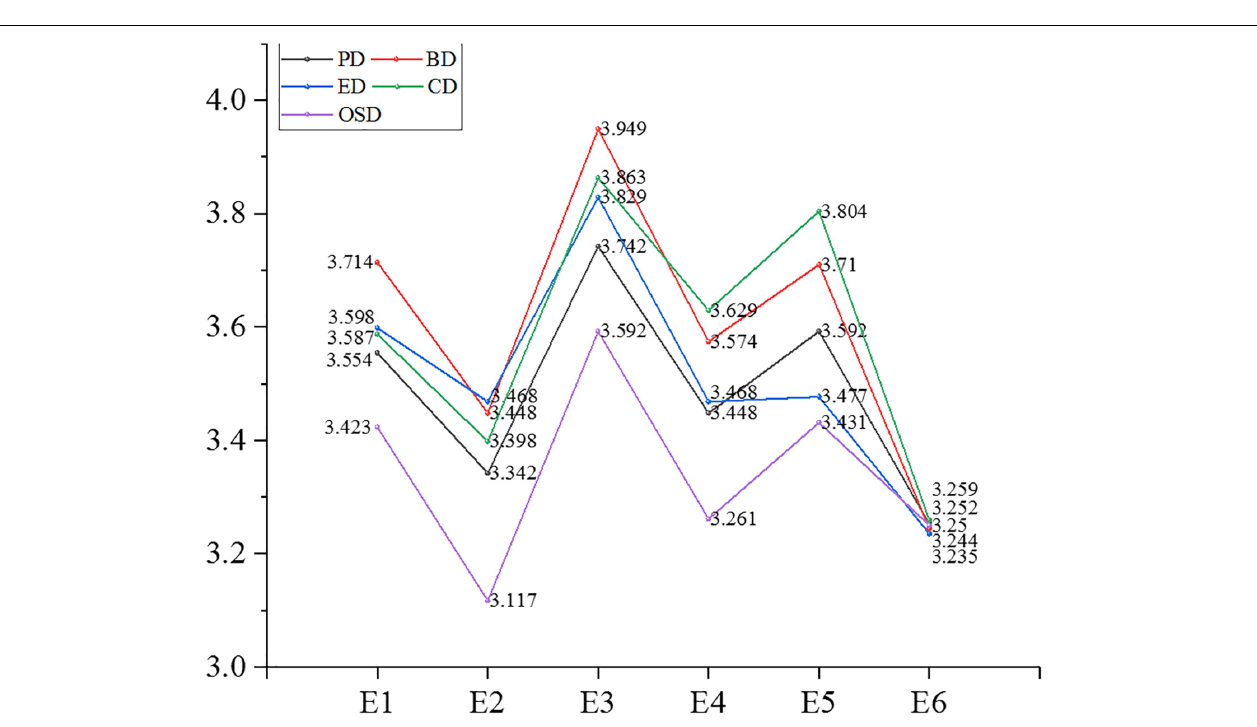
FIGURE 8 | Mean value of Psychological distance and dimensions thereof in the educational